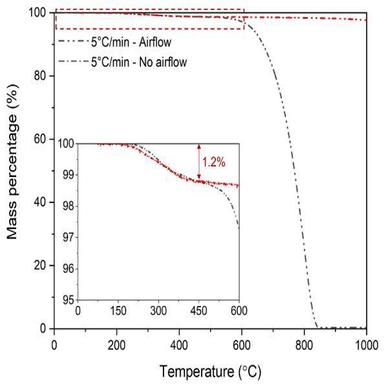
TGA results of pure CFs in a 50 ml/min airflow and in static air conditions with a heating rate of 5 ◦C/min and detail of the results up to a 95% remaining mass (temperature window: 0–600◦C).